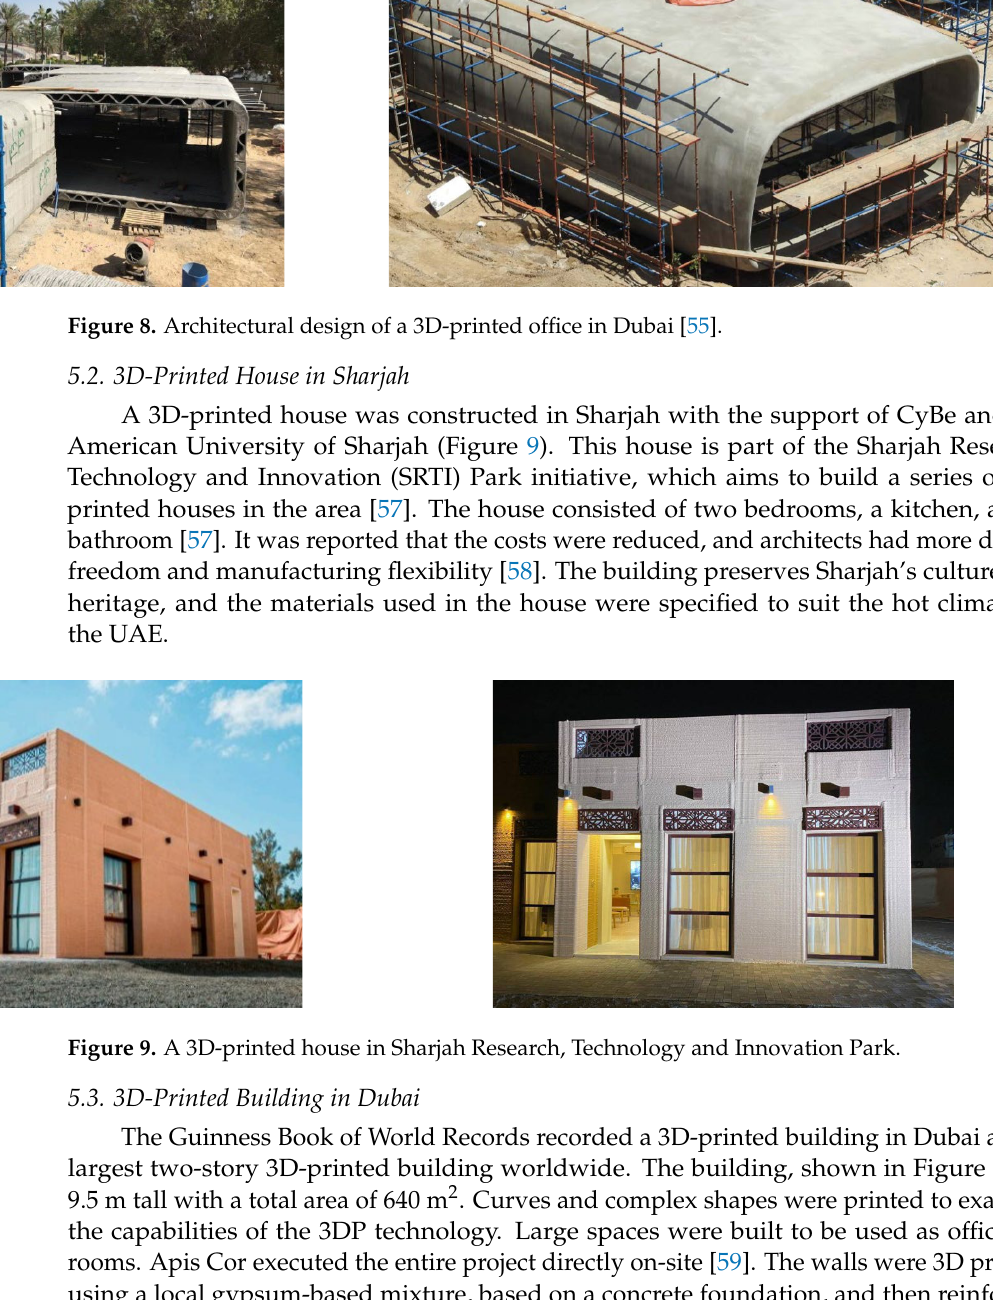
Figure 10. Largest 3D-printed two-story building in Dubai during and after construction [59].